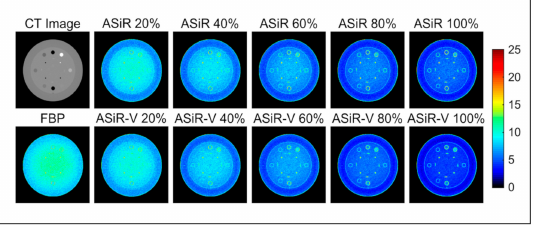
Figure 2. Noise maps (HU) of a CT image of the CTP404 phantom module reconstructed using FBP and ASiR/ASiR-V with different blending levels (20%, 40%, 60%, 80%, and 100%). The corresponding FBP-reconstructed CT image of the phantom is also displayed.